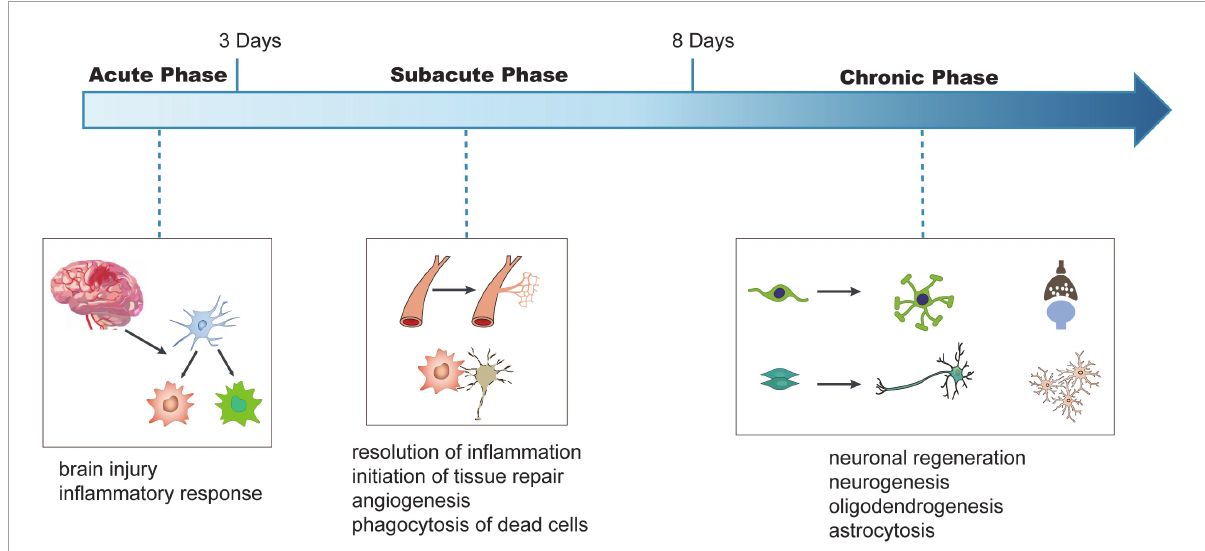
FIGURE1 Schematic viewing of time-dependent key injury and repair processes after ischemic stroke. In this review, we refer to Days 1–3 after stroke onset as the acute phase, Days 3–8 being subacute phase, and days exceeding 8 being chronic phase. We illustrate the conceptual changes in each phase. In the acute phase, ischemia in the brain leads to the injury of the brain and inflammatory responses. In the subacute phase, the resolution of inflammatory response and phagocytosis of dead neurons were observed and tissue repair processes, such as angiogenesis, are initiated. During the chronic phase, processes, such as neurogenesis, oligodendrogenesis, and astrocytosis are initiated to regulate neuronal regeneration and functional recovery.